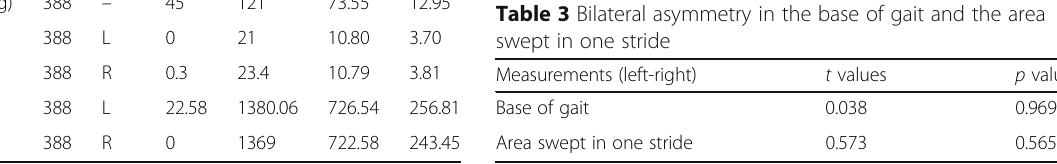
Table 3 Bilateral asymmetry in the base of gait and the